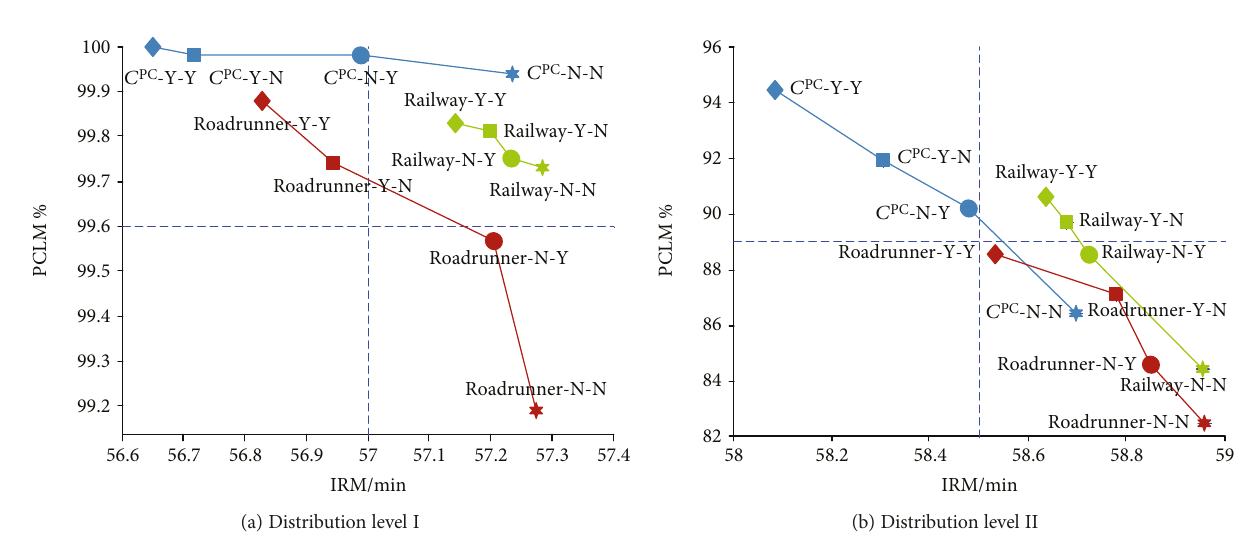
Figure 12: Results of resource allocation scheme combinations and scheduling policies under mission case